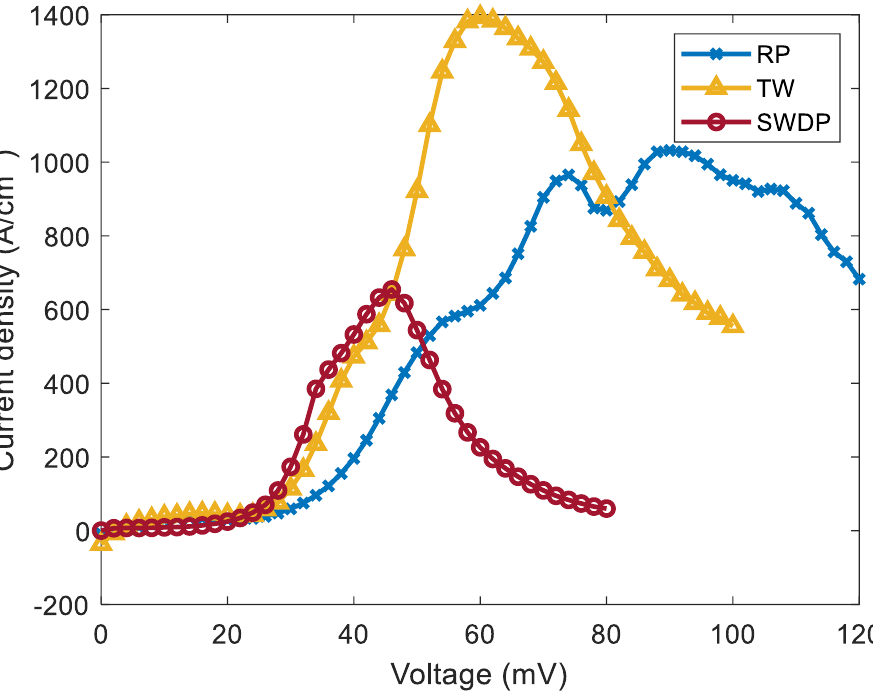
Figure 4. Current density – voltage curves for RP, TW, and SWDP designs at 10 K.